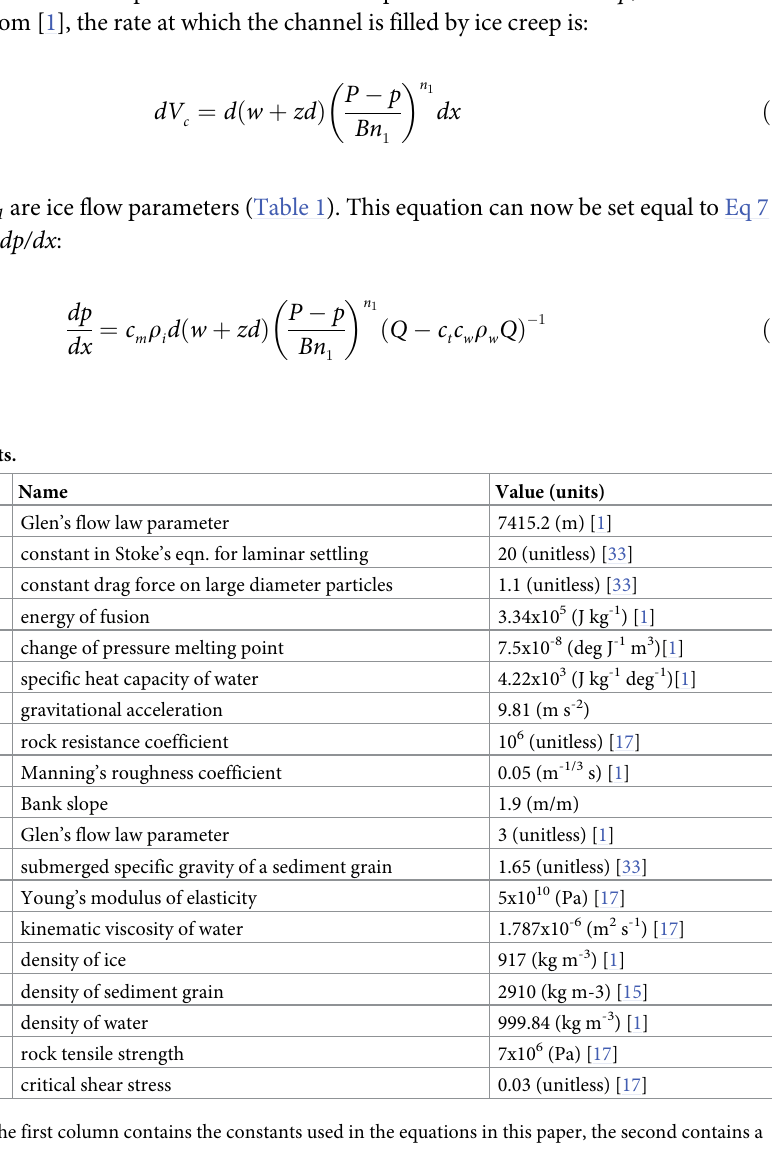
Source: Table 1. The first column contains the constants used in the equations in this paper, the second contains a brief description of them and the third contains their numerical values. Numbers in squared brackets in the third column refer to the papers from which these constants were